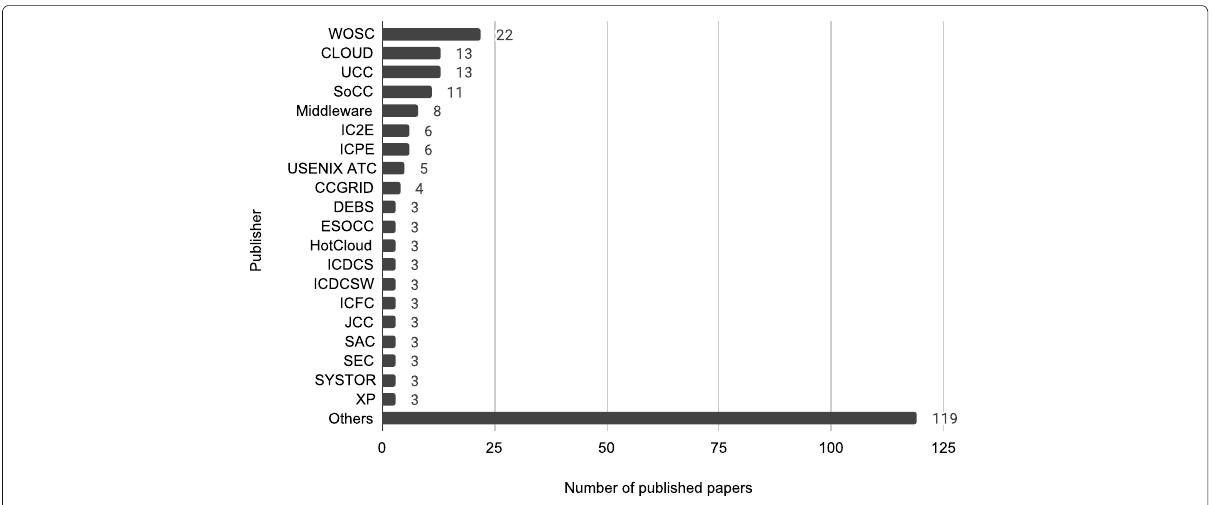
Fig. 6 Published papers vs. conference name